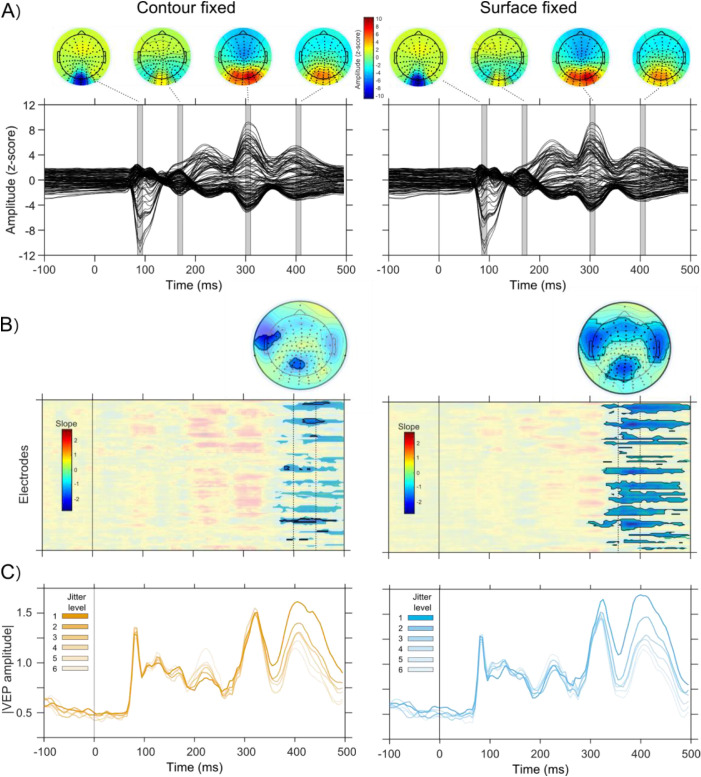
EEG results. (A) Grand-averaged VEPs of Contour and Surface fixed condition, respectively, with corresponding voltage topographies at the peak of four observed evoked components. (B) Shows slope estimates (in time for each electrode) of VEP-jitter regression in the two conditions. All statistically significant clusters (corrected for multiple comparisons) are highlighted. Within these clusters, black boundaries highlight regions where slope values that fell within the 95% confidence interval (CI) of the behavioral d′ slopes. The corresponding scalp distribution of slopes is shown on top (significant electrodes highlighted), in the interval delimited by the vertical dashed lines. (C) Grand-averaged traces across the central electrodes identified B, illustrates the linear decrease in amplitudes with increases in cue jitter for the two conditions.